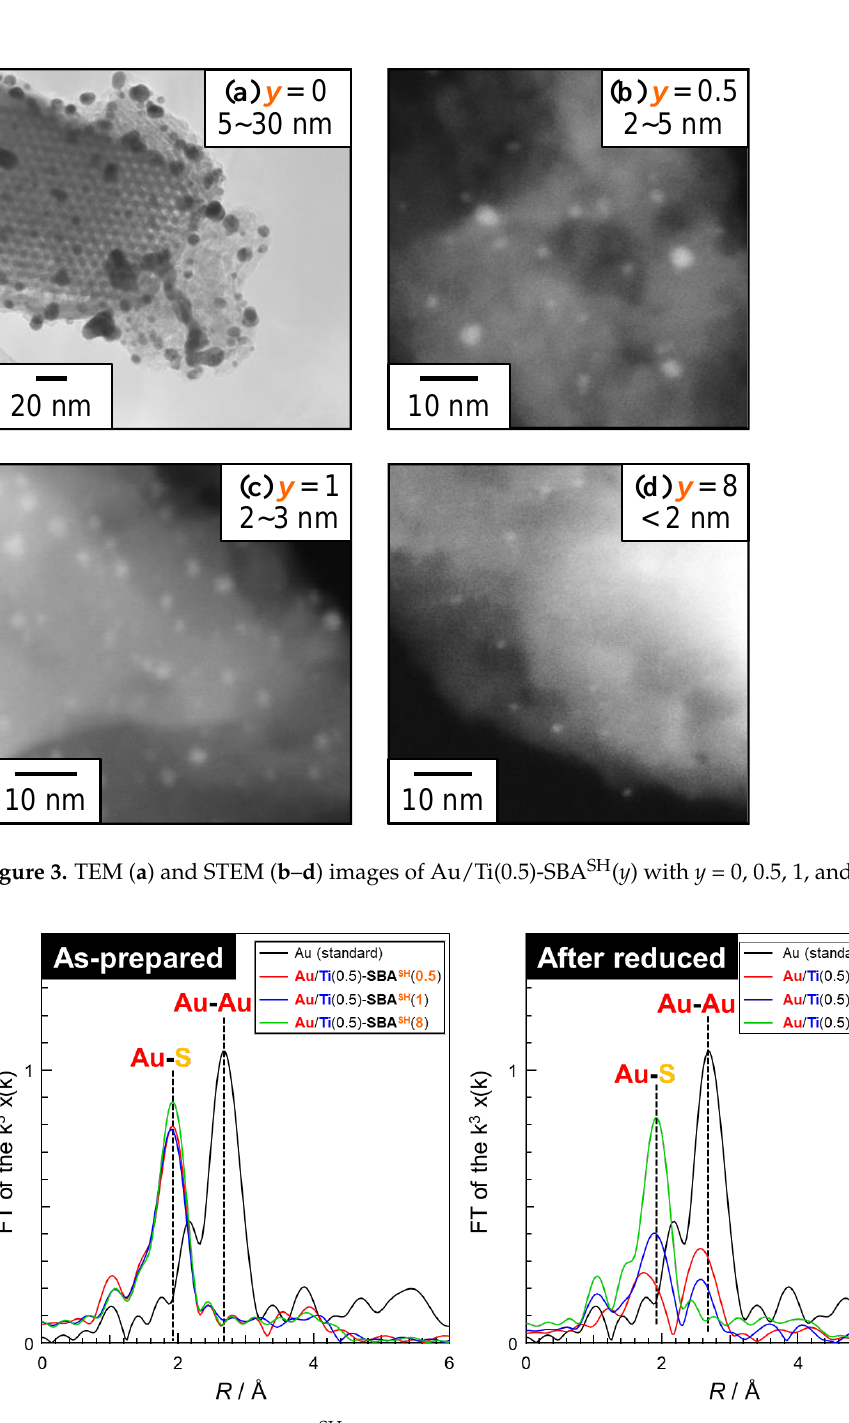
Figure 4. XAFS of Au/Ti(0.5)-SBA SH ( y ) with y = 0, 0.5, 1, and 8.